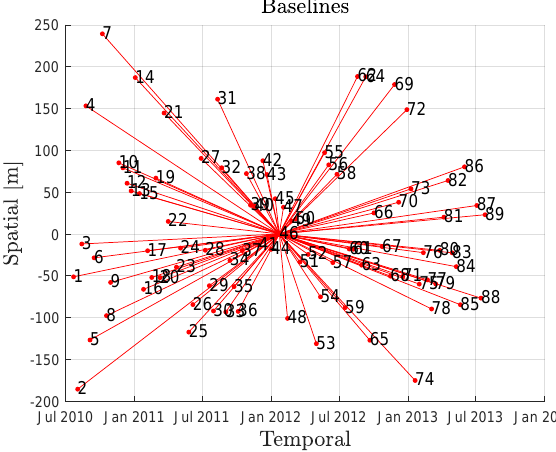
Figure 1. Temporal and spatial baselines, relative to the master image from 23rd January 2012. The 89 images were acquired between 22nd July 2010 and 26th July 2013, with a repeat interval of 11 days.